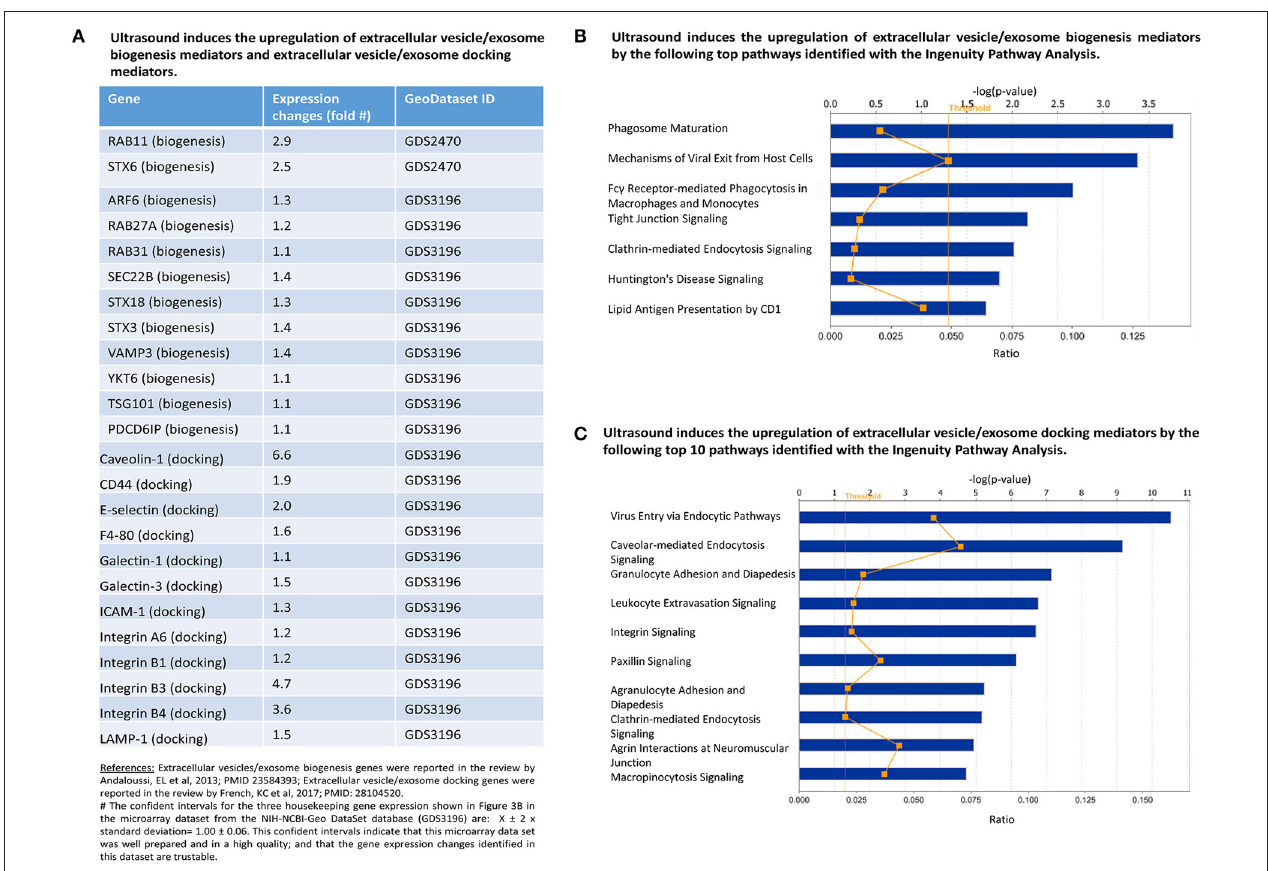
FIGURE 5 | LIUS therapy increases markers of exosome biogenesis and docking . (A) List of exosome biogenesis and docking genes that were upregulated with LIUS therapy. (B) The signaling pathways that are affected by the exosome biogenesis genes that are upregulated with LIUS treatment. (C) The major signaling pathways that are regulated by the exosome docking genes that had increased expression with LIUS therapy.